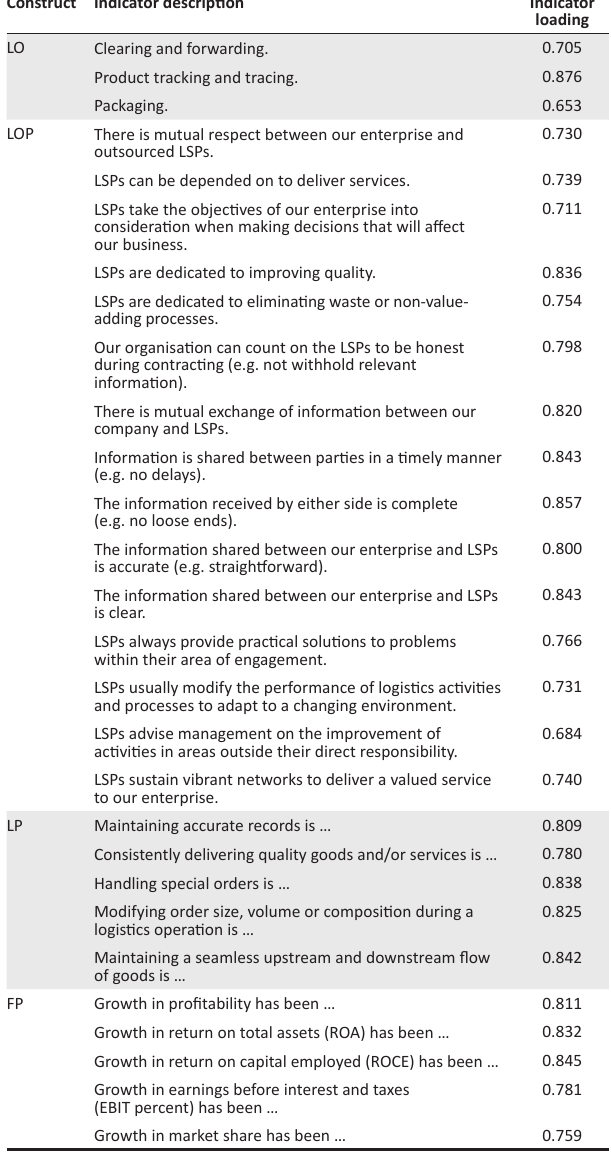
TABLE 2: Indicator outer loadings extracted from final structural equation modelling model.